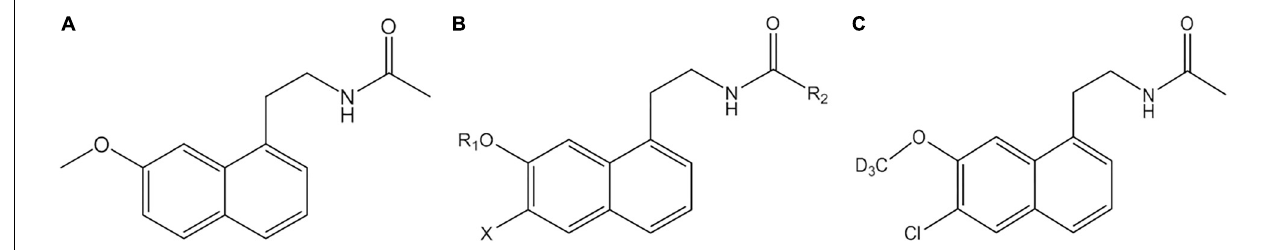
FIGURE 1 | Structure of AGO (A) , structure of the series derivatives of AGO (B) , and GW117 (C) . X are H or halogen atoms; R 1 are CH 3 or CD 3 ; R 2 are CH 3 , CD 3 , or C 2 H 5 .